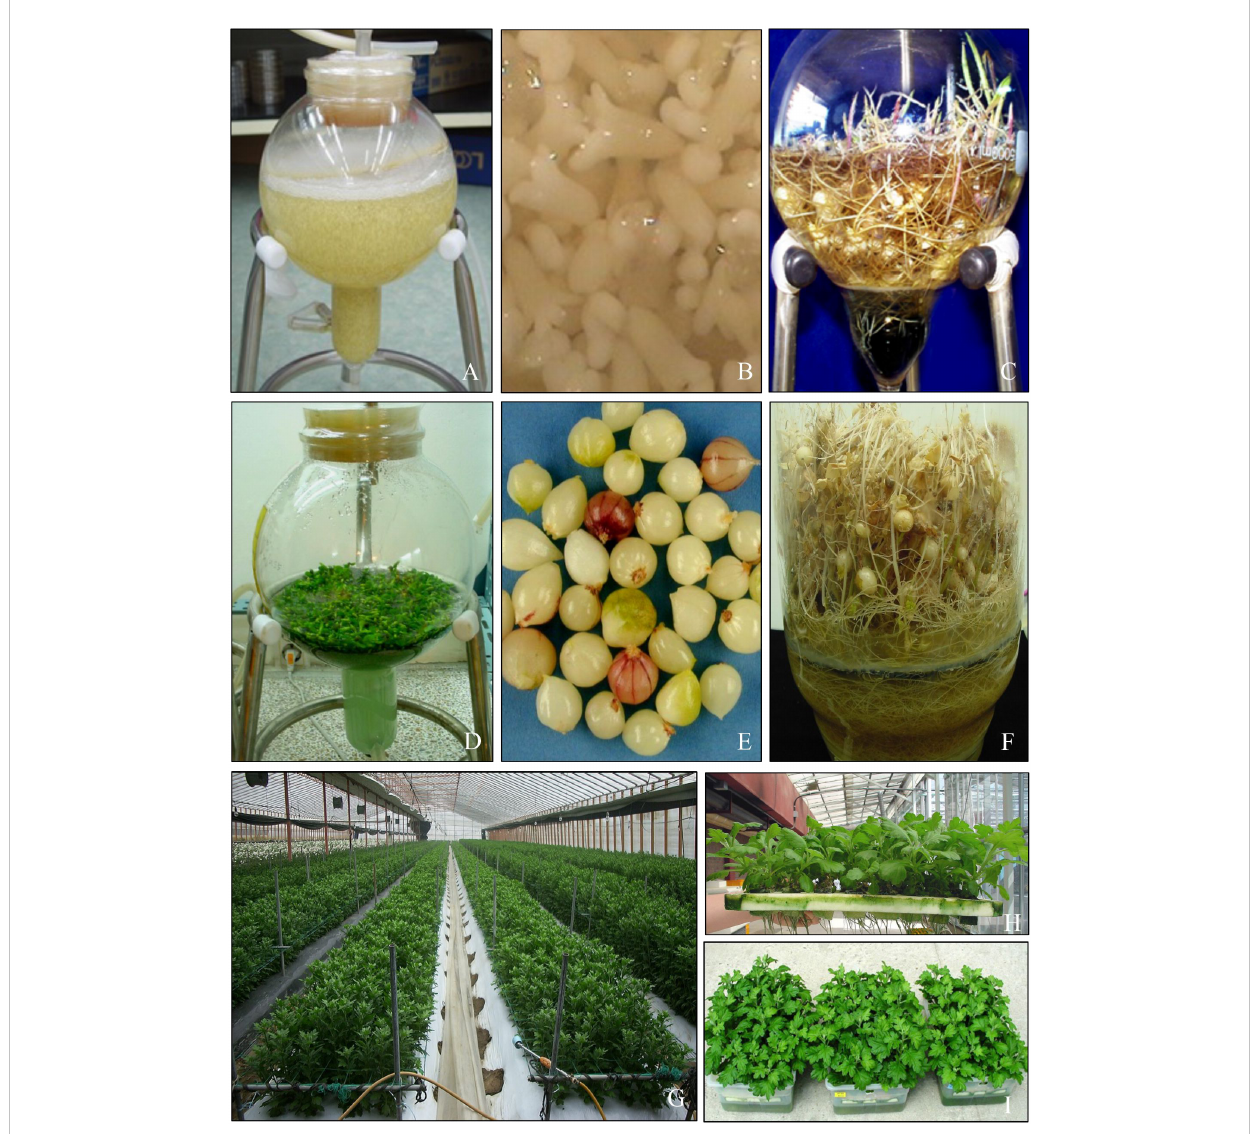
FIGURE 4 Application of bioreactors for micropropagation. (A, B) Somatic embryos of Siberian ginseng cultured in balloon-type bubble bioreactor. (C) Lilium bulblets cultured in balloon-type bubble bioreactor. (D) Phalaenopsis PLBs cultured in balloon-type bubble bioreactor with raft system. (E) Garlic bulblets harvested from balloon-type bubble bioreactor. (F) Potato microtubers developed in vertical column bioreactors. (G) Chrysanthemum plants in the greenhouse. (H, I) Chrysanthemum plantlets after ex vitro rooting by hydroponic method and direct planting to the potting medium by dipping in indole acetic acid